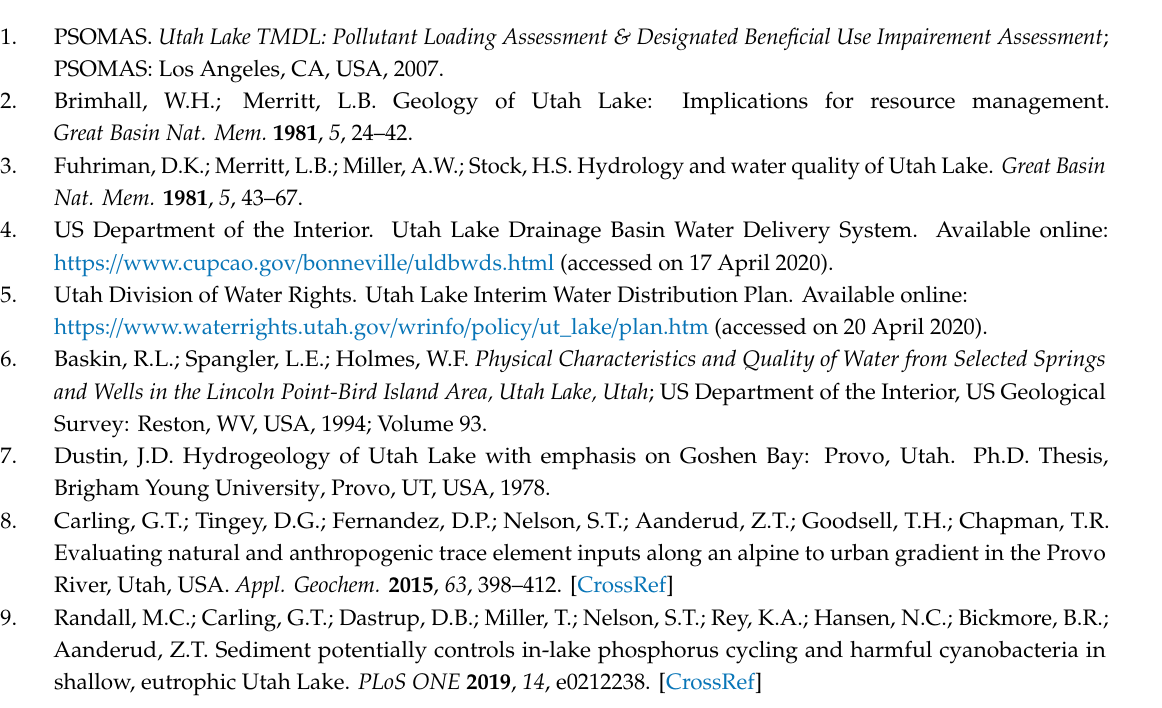
in Tables S1–S5. Table S1: Biweekly Samples. Table S2: Meteoric Precipitation. Table S3: Utah Lake Depth Profiles. Table S4: Utah Lake Horizontal Profiles. Table S5: Utah Valley Shallow Groundwater